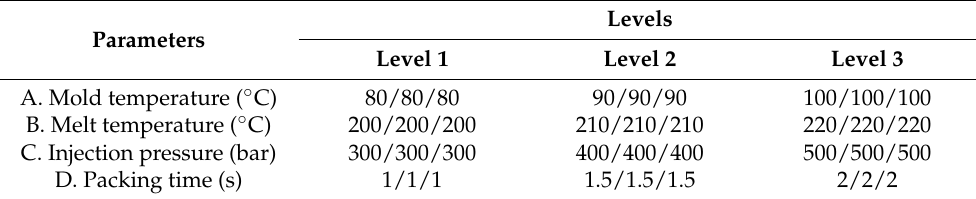
Table 2. Processing parameters for